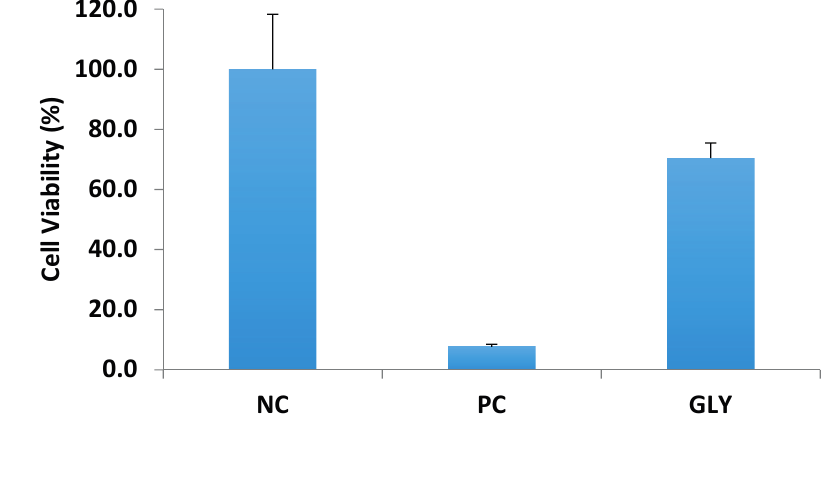
Figure 4. Assessment of glycopyrrolate dermal irritation. NC = negative control (saline), PC = positive control (5% sodium dodecyl sulfate), GLY = glycopyrrolate solution. All values represent mean ±